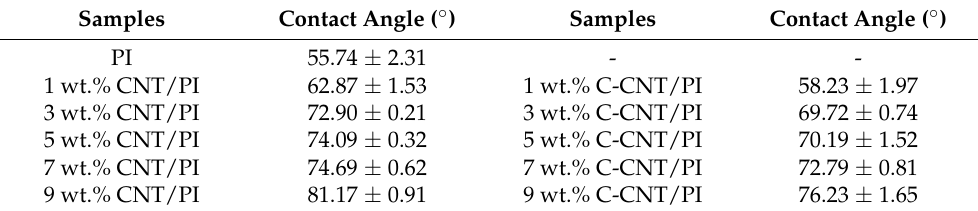
Table 3. The water contact angles of PI, CNT/PI and C-CNT/PI